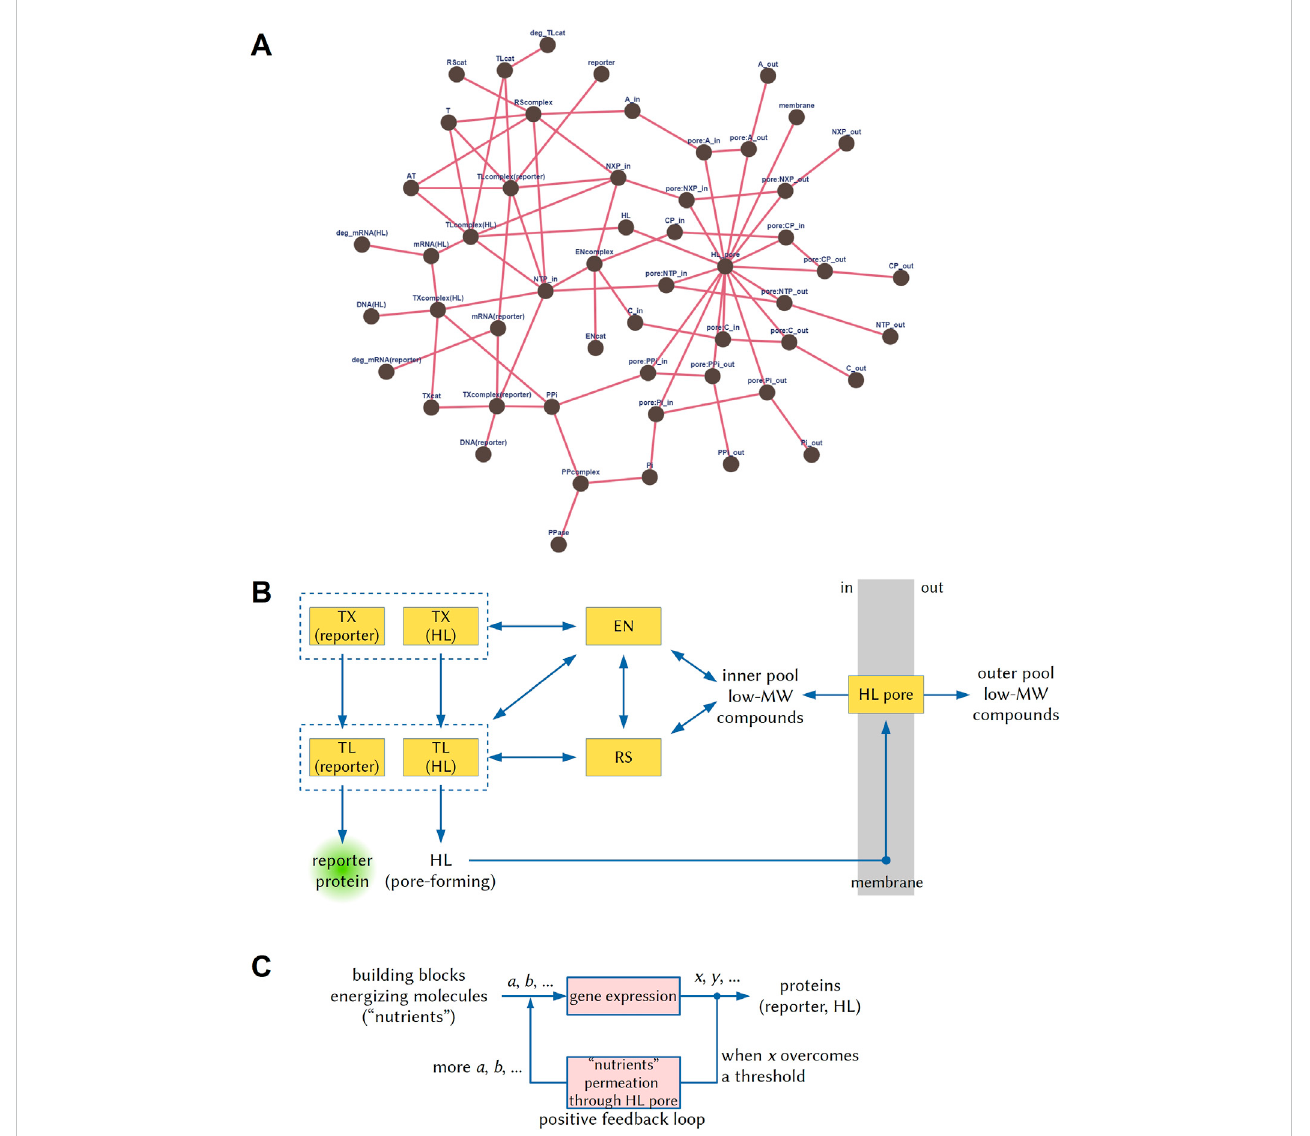
FIGURE 1 Graphical representations of the three hierarchical network-based approaches to describe ACs, i.e., the reductionist, mesoscopic, and systemic ones (Gentili, 2021). (A) The network of reactions occurring in the ACs drawn according to the reductionist approach, using the reaction set and the species described by (Mavelli et al., 2015) (details in the SI fi le). (B) The same network drawn according to the mesoscopic approach. TX: transcription; TL: translation; EN: energy recycling; RS: tRNA aminoacylation; HL: α -hemolysin; MW: molecular weight. (C) The systemic description refers instead to the network operationsandtheirfunctionalsigni fi cance.Inthiscase, via geneexpression,asetofsubstrates( a , b ,...),whichareaminoacids,nucleotidestriphosphate, etc. , are transformed into a set of products ( x , y , ...), which include the reporter protein and the α -hemolysin. When the latter generate a membrane pore, a new processcantake place,i.e.,thediffusionofsubstrates fromtheexternal volumetotheACinternalvolume,leadingtoasustained geneexpression – inasortof positive feedback